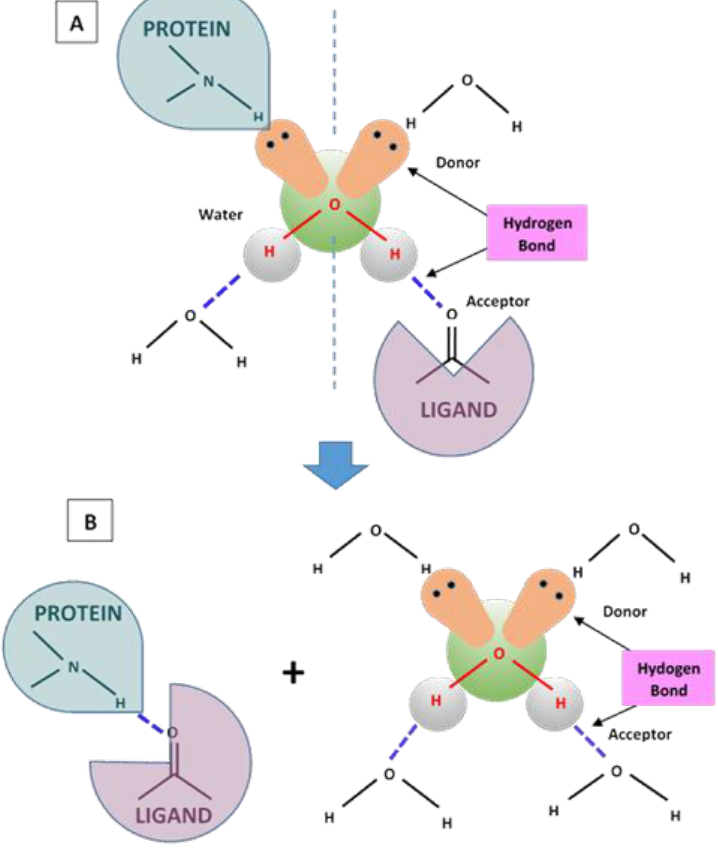
Figure 6. Hydrogen bond mechanism (solvation-desolvation) involved before ( A ) and after ( B ) the formation and structural organization of a ligand-protein complex.